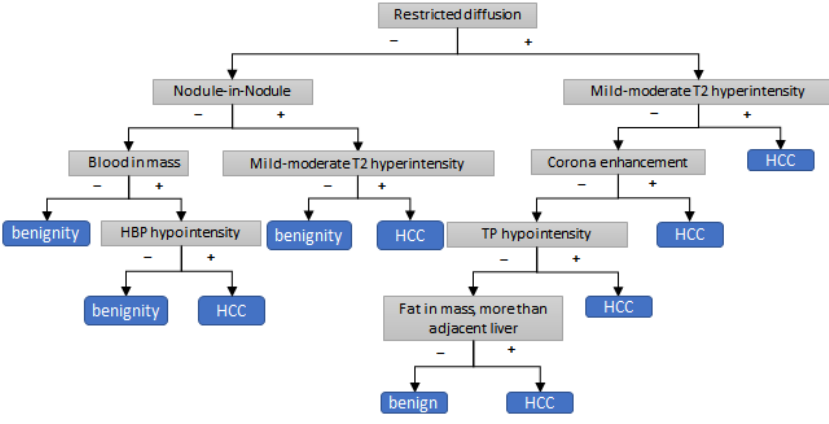
Figure 2. Decision tree algorithm for applying ancillary features to LR3 and LR4 categories.